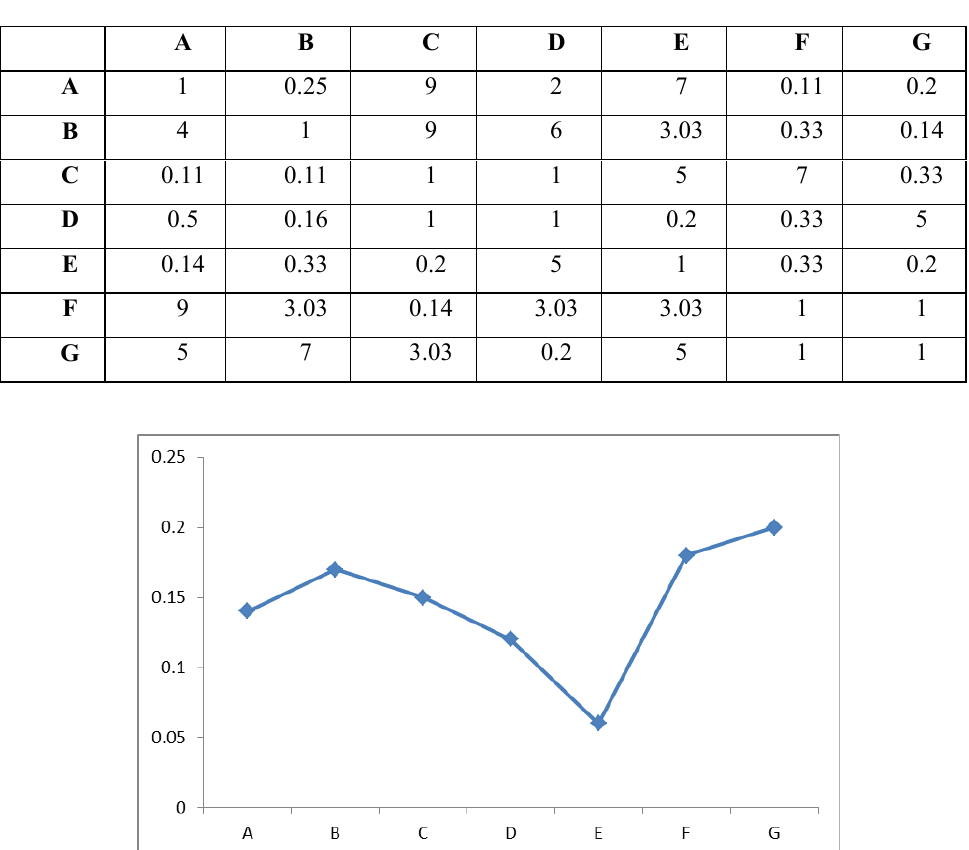
Table 1. Column Mean of the Final Results, the Final Values of Each Index (developed by the authors)